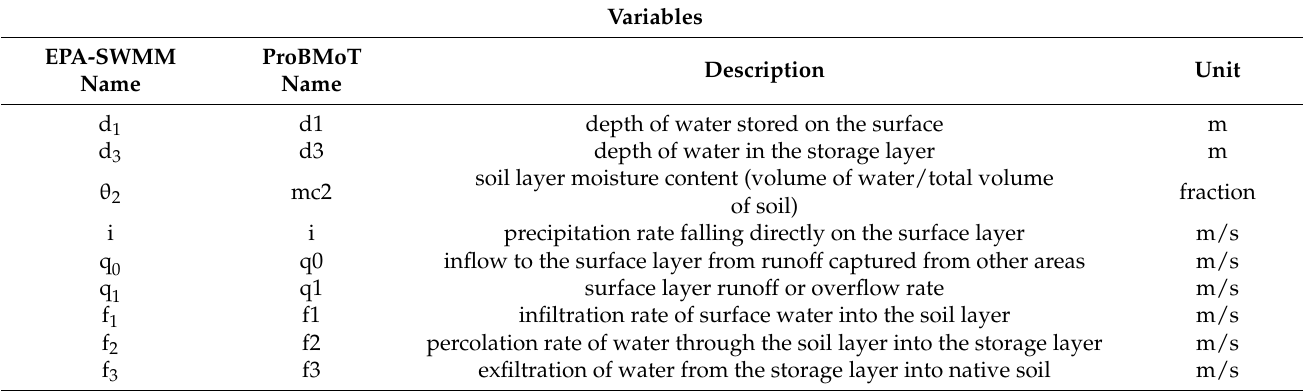
Table 4. Variables used for stormwater control measures. Variables